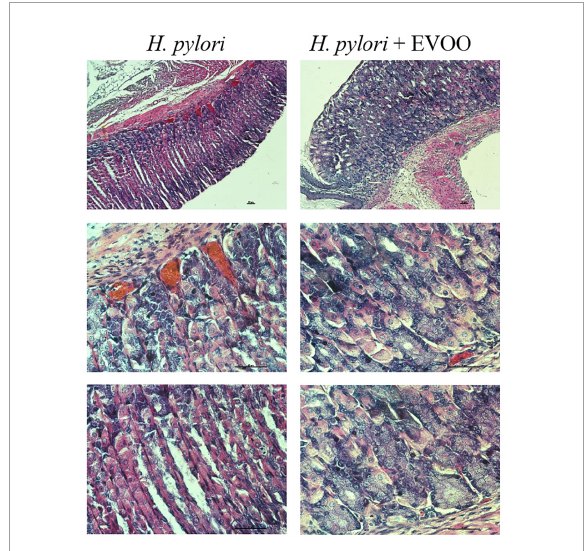
FIGURE7 Hematoxylin–Eosin stain of Helicobacter pylori group and H. pylori and treatment group at 15 days. The mucosa of animals infected with H. pylori shows structural alterations, such as an increase of the gland gastric, vasodilation, and increased blood supply. The mucosa of animals infected with H. pylori and treated simultaneously with EVOO show morphological characteristics similar to those of normal and EVOO mucosa, even though slight vasodilation is observed. Scale bar: 40 µ m.